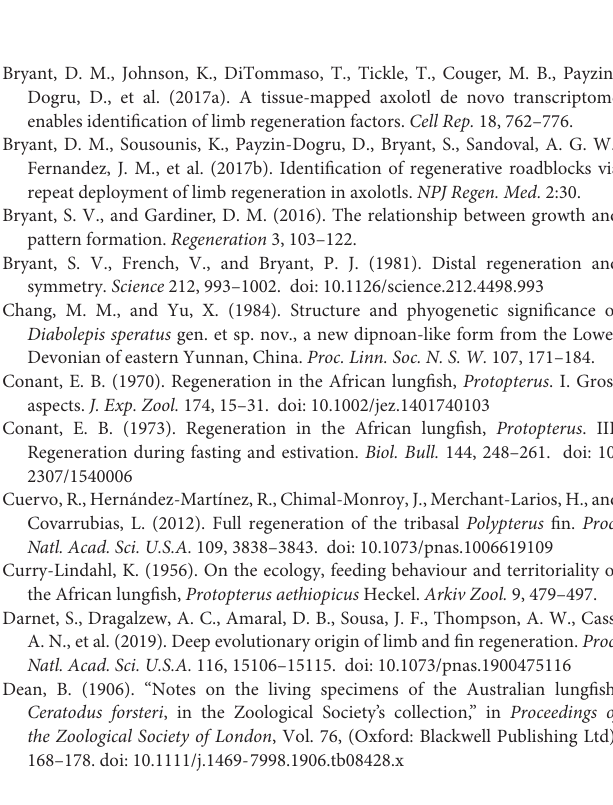
Supplementary Figure 1 | Pectoral fins of three lungfish, Neoceratodus forsteri . (A–F) Fins with obvious signs of fin regeneration. (G–L) Same fins after two years with no significant changes in shape. Supplementary Table 1 | Histological staining protocol for Heidenhain’s Azan. Supplementary Table 2 | Histological staining protocol for Alcian blue/nuclear fast